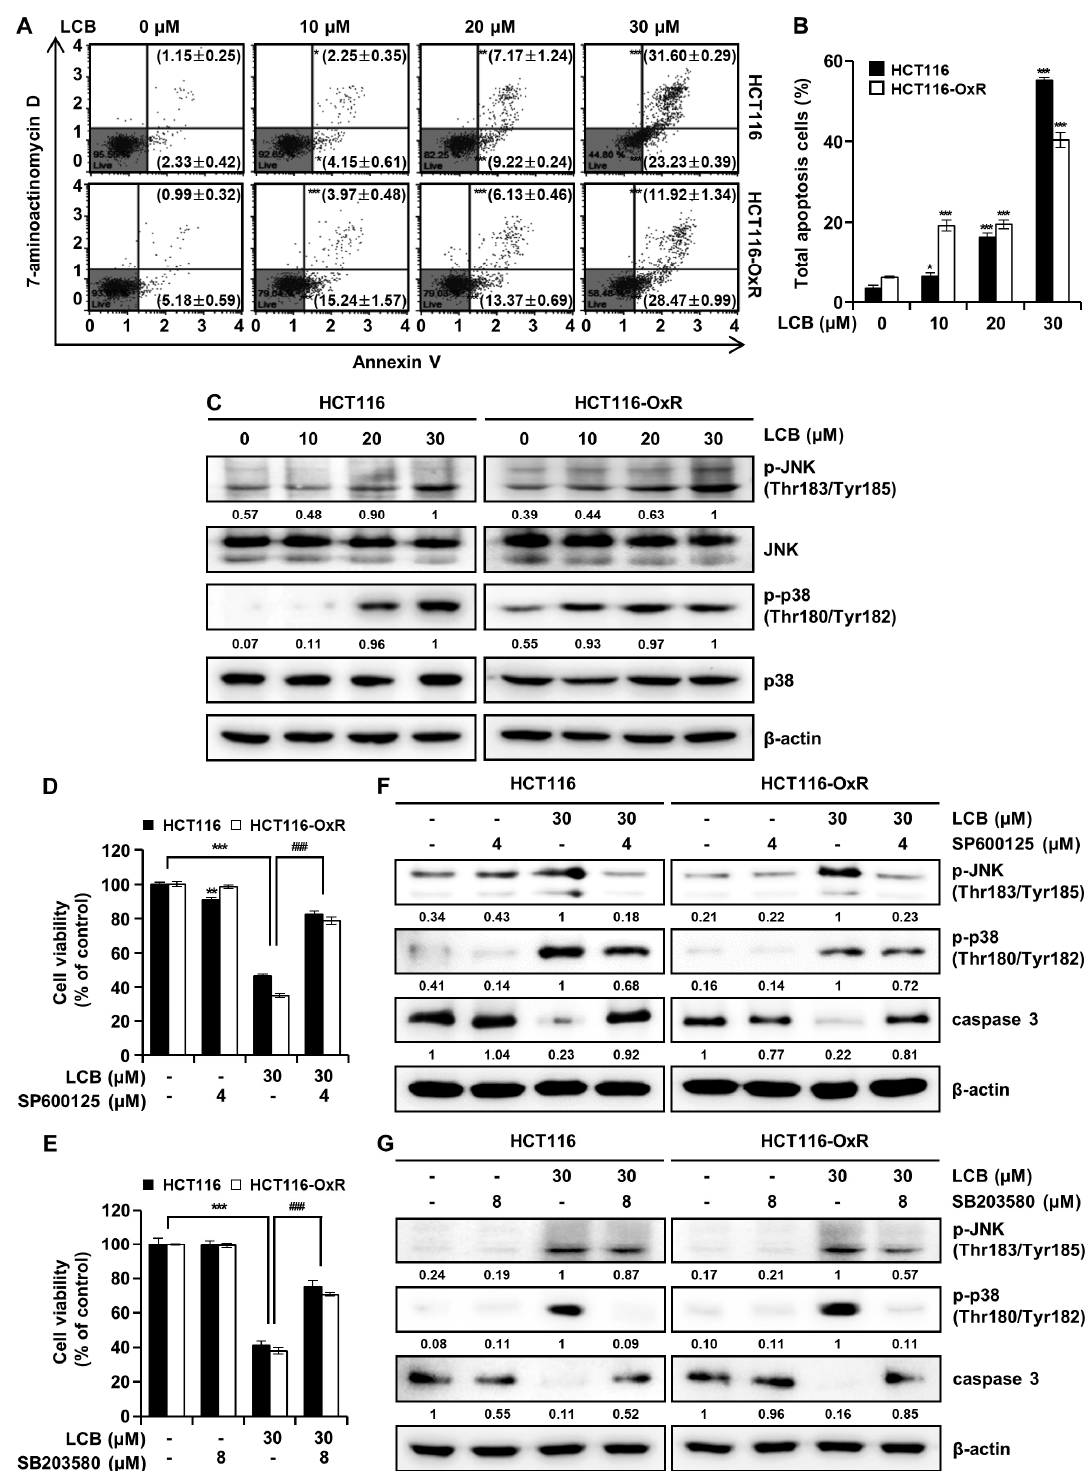
Figure 2. LCB induces apoptosis and causes phosphorylation of JNK/p38 MAPK in human CRC cells. Cells were treated with LCB at 0, 10, 20, and 30 µ M for 48 h. ( A ) Annexin V/7-aminoactinomycin D (7-AAD) flow cytometry analysis of CRC cells. Early and late apoptotic cells are represented in the lower right quadrant (Annexin-V-positive and 7-AAD-negative) and upper right quadrant (Annexin-V-positive and 7-AAD-positive), respectively. ( B ) Percentages of early and late apoptotic cells after LCB treatment of CRC cells. ( C ) Western blot showing the expression levels of p-JNK,